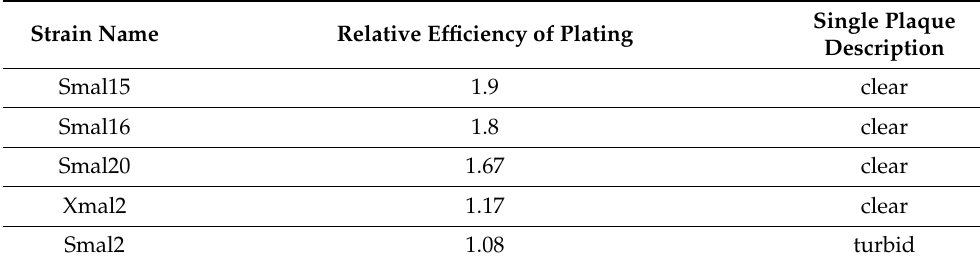
Table 2. Efficiency of plating (EOP) of phage Ps15 on different bacterial hosts expressed as the ratio of the phage titre of the tested strains and the titre of the propagating host strain (2.1 × 10 8